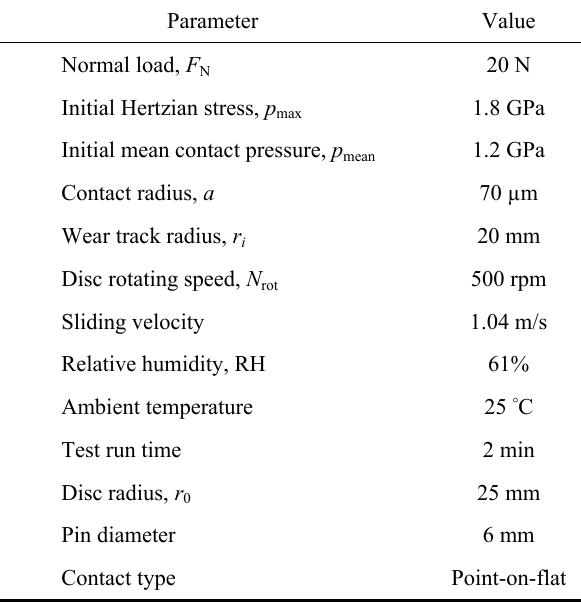
Fig. 1 Schematic of pin-on-disc configuration. Table 1 Experimental conditions for short duration